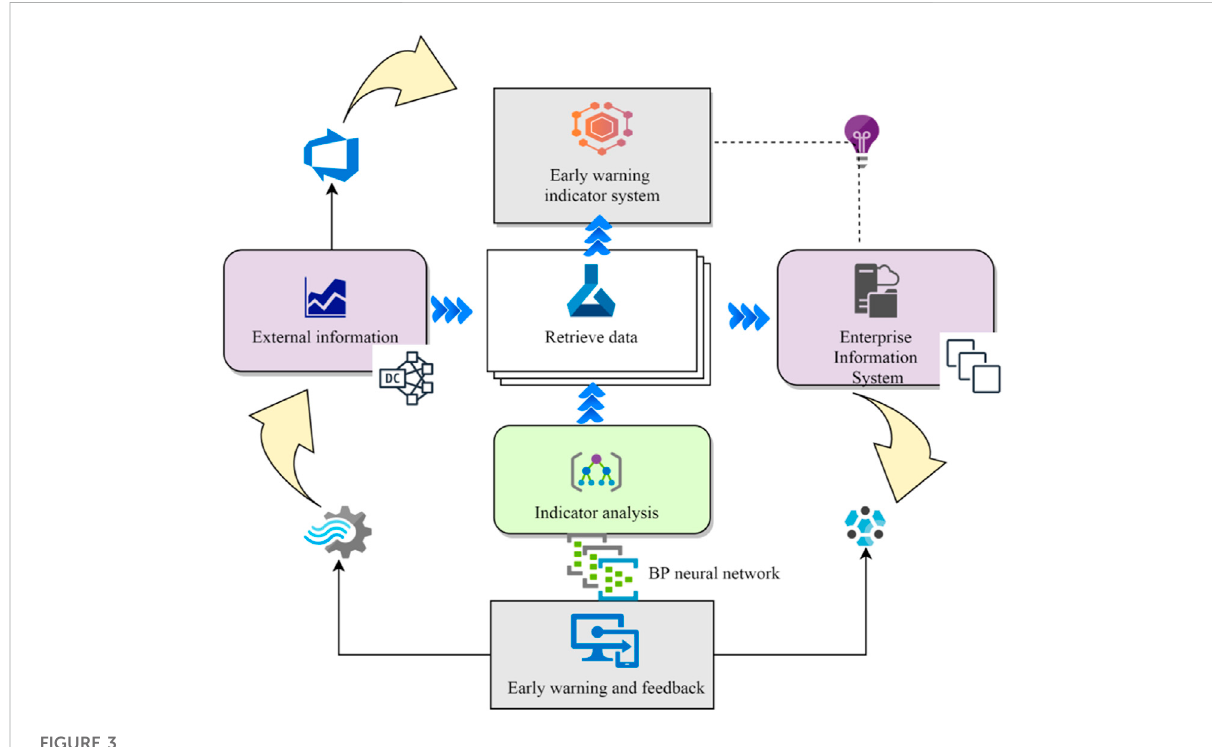
FIGURE 3 Basic process of fi nancial early warning model based on